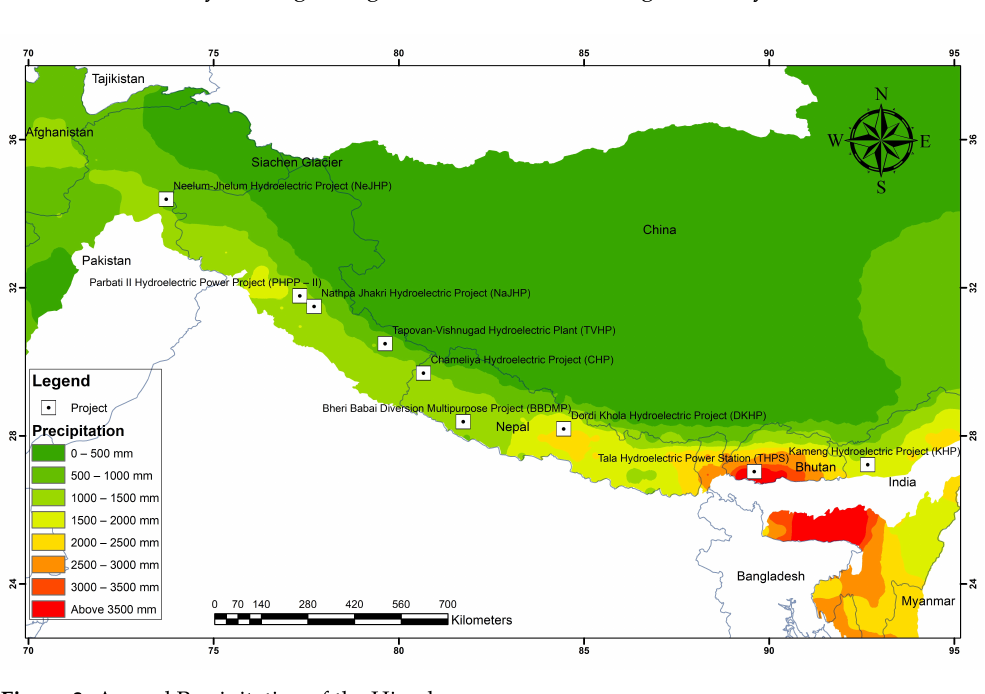
Figure 3. Annual Precipitation of the